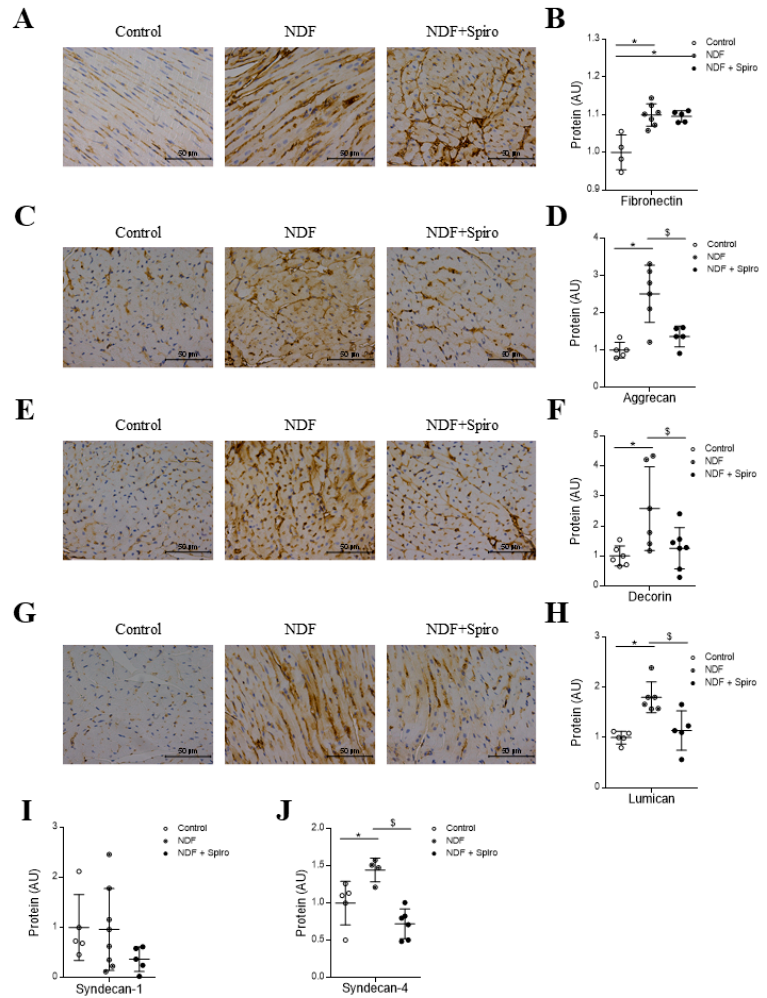
Figure 3. Effect of spironolactone treatment on the expression of non-fibrillar proteins in a mouse model of mitral valve fibromyxomatous degeneration. Representative microphotographs of fibronectin, aggrecan, decorin and lumican immunostainings are shown ( A , C , E , G ). The protein expressions of fibronectin (* p = 0.0005 Control vs. NDF; * p = 0.0013 Control vs. NDF + Spiro), aggrecan (* p = 0.0008; $ p = 0.0072), decorin (* p = 0.0209; $ p = 0.0459), lumican (* p = 0.0017; $ p = 0.0072), syndecan-1 and syndecan-4 (* p = 0.032; $ p = 0.0009) were measured by ELISA (Enzyme-Linked Immuno Sorbent Assay) in myocardium from controls, NDF-treated mice and NDF + Spiro-treated mice ( B , D , F , H – J ). The box plots show the individual datapoints and the horizontal bars indicate the mean and SEM in arbitrary units versus the control group. Magnifications 40 × (Scale bar 50 µ m). The results were analyzed one-way ANOVA, followed by Tukey’s multiple comparisons tests. * vs. control, $ vs. NDF.